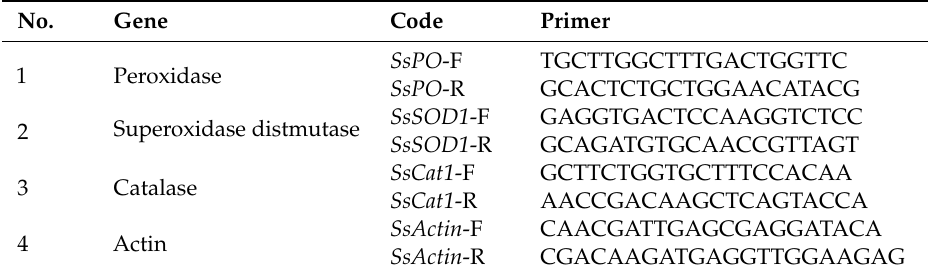
Table 1. List of oligonucleotides used to study the expression of ROS-scavenging genes in Sclerotinia sclerotiorum through